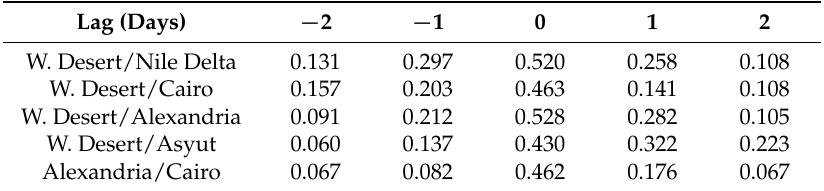
Table 4. Cross-correlation between AOD from different areas with time lag varies between − 2 and +2 days. N/A indicates an insufficient number of points for